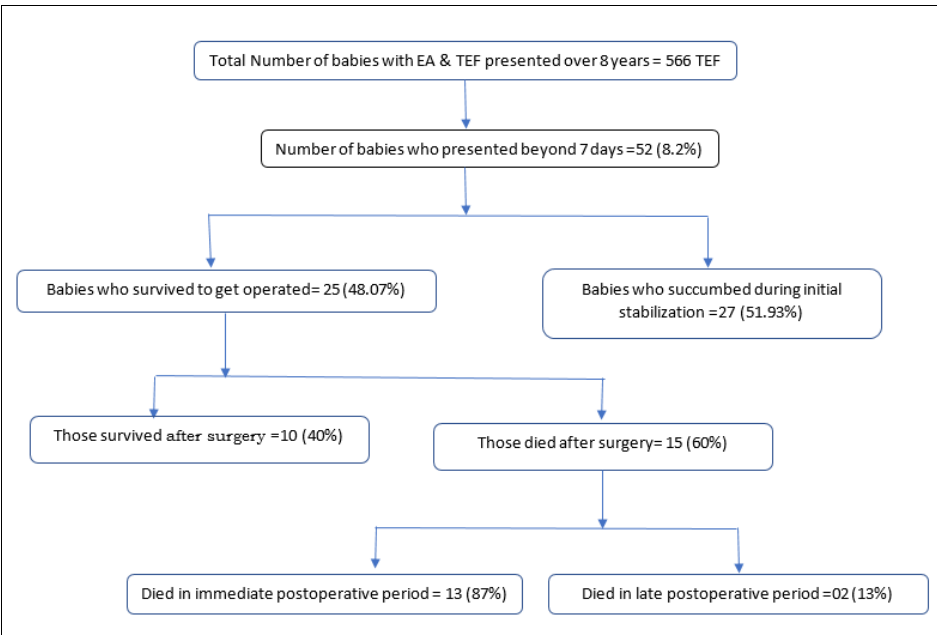
Figure 1: Flowchart showing the study population and outcome